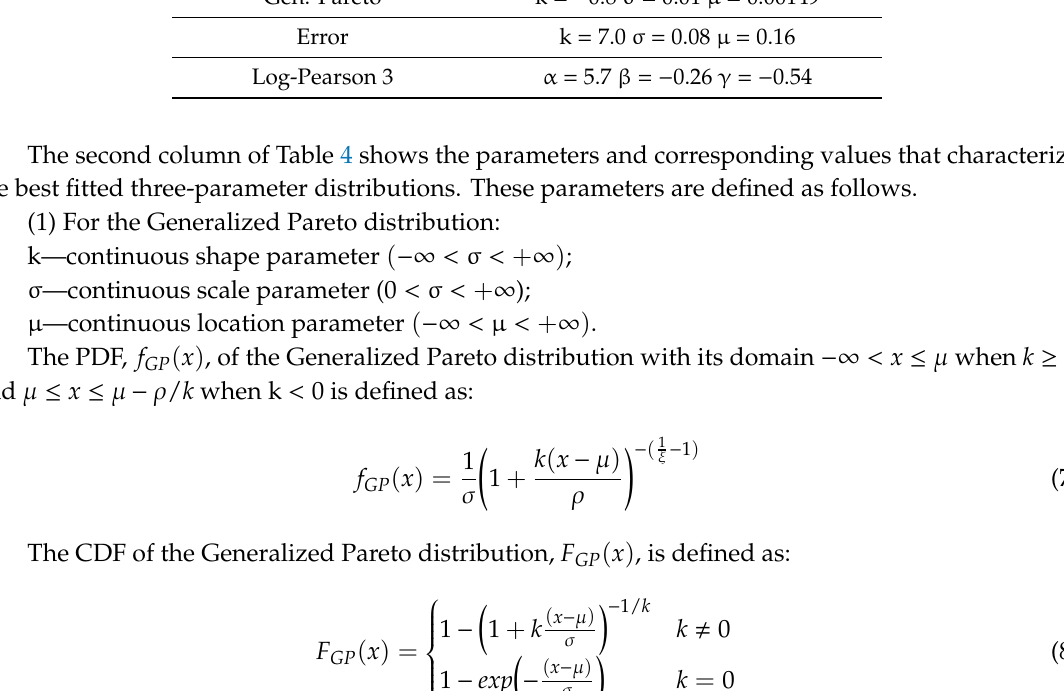
Table 4. The three best fitted three-parameter distributions of c 1